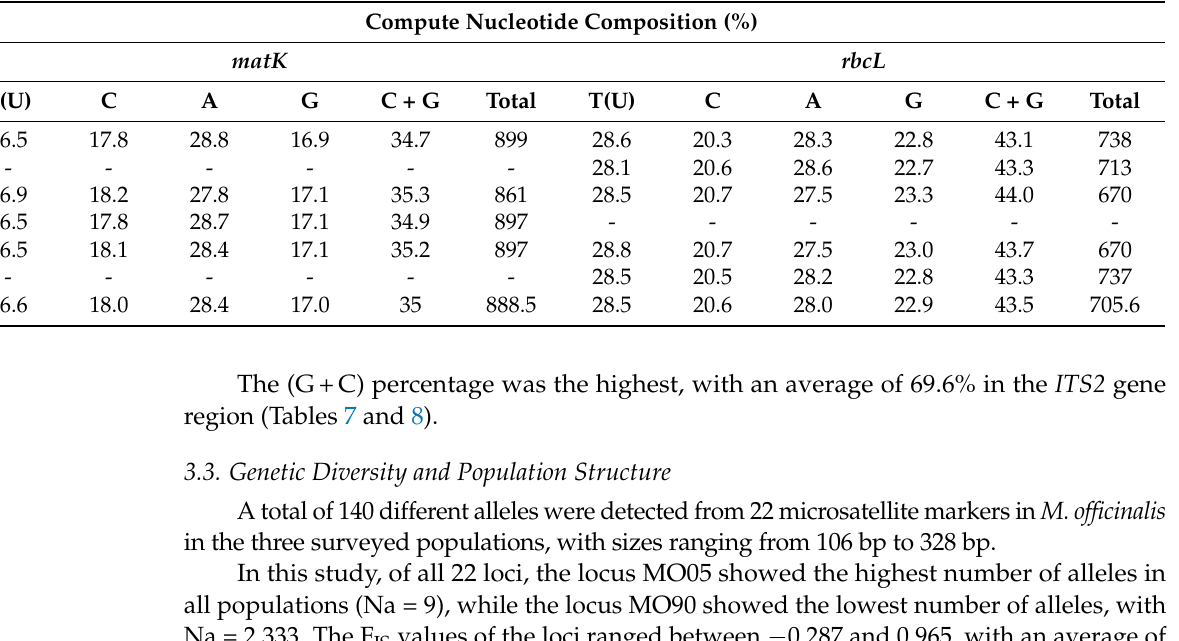
Table 8. Nucleotide components of the matk and rbcL gene regions of four M. officinalis